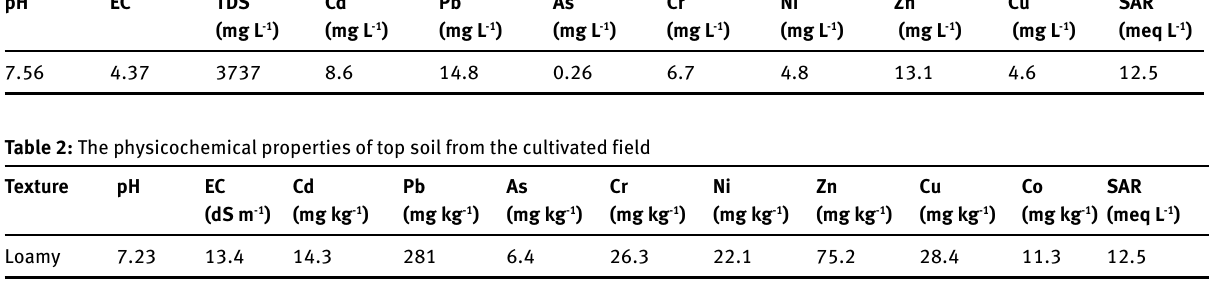
Table 1: The physicochemical properties of wastewater samples used for irrigation of crops production in fields in Kahrizak, located in the southern suburb of Tehran pH EC